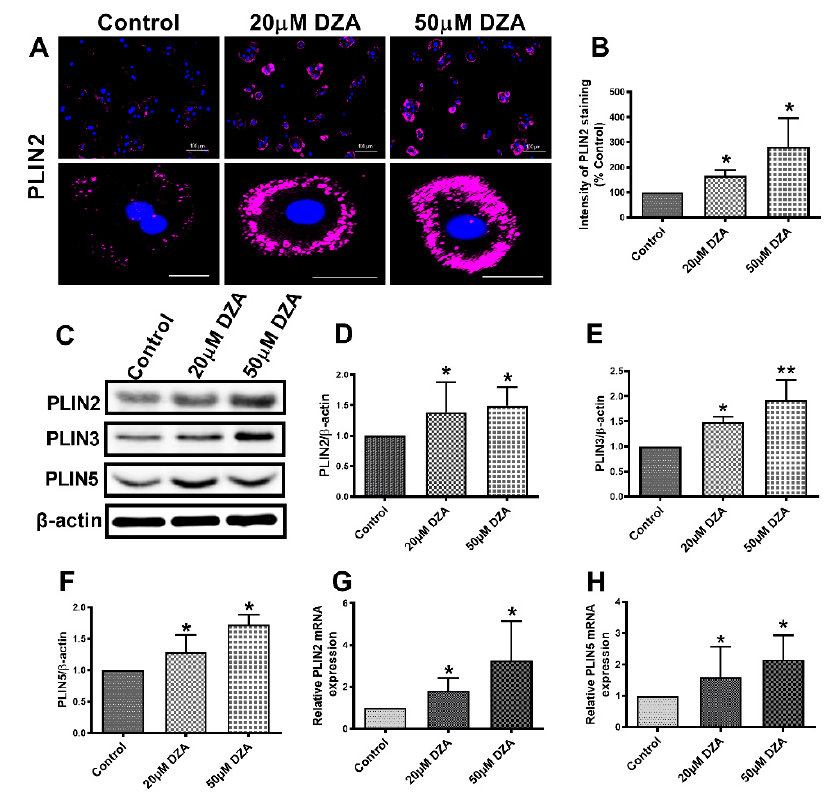
Figure 2. The expression of PLINs in control and DZA-treated hepatocytes. ( A ) Images of PLIN2 staining in representative control and DZA-treated hepatocytes; scale bar 100 µm (upper panel) and 20 µm (lower panel). ( B ) The fluorescence intensity of PLIN2 expression in each group of cells normalized to % of control cells, n = 3 experiments; images of 30 random cells from each treatment group per experiment were captured and analyzed. ( C ) Representative Western blot showing PLIN2, PLIN3 and PLIN5 levels in control and DZA-treated cells. ( D ) Immunoblot analysis summarizing the protein band density of PLIN2, ( E ) PLIN3 and ( F ) PLIN5 to β -actin, n = 3 experiments. ( G ) Relative PLIN2 mRNA and ( H ) PLIN5 mRNA expression in control and DZA-treated hepatocytes, n = 4–7 experiments. Asterisks indicate values for DZA-treated hepatocytes are statistically different from controls (* p ≤ 0.05 vs. Control; ** p < 0.01 vs. Control).